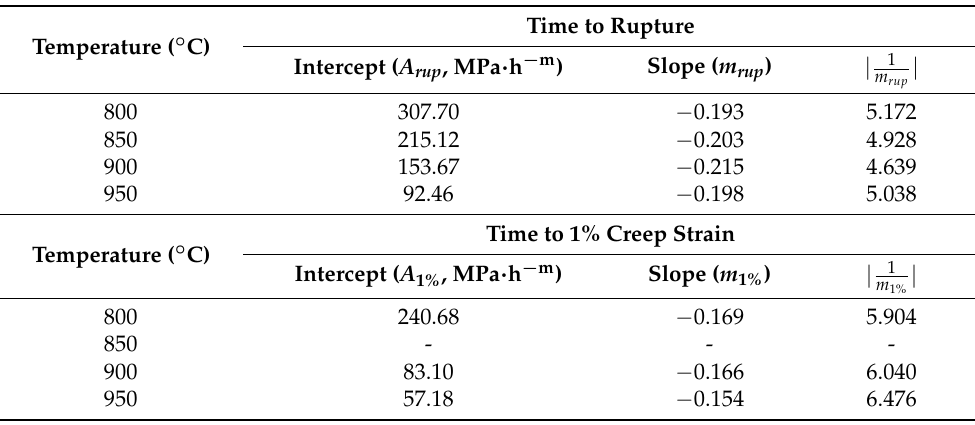
Table 3. The intercept and slope in the power-law function (Equation